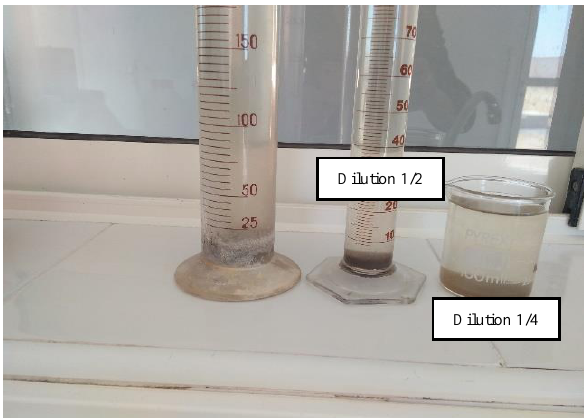
Illustration 2. Measures the sludge index of the aerobic reactor